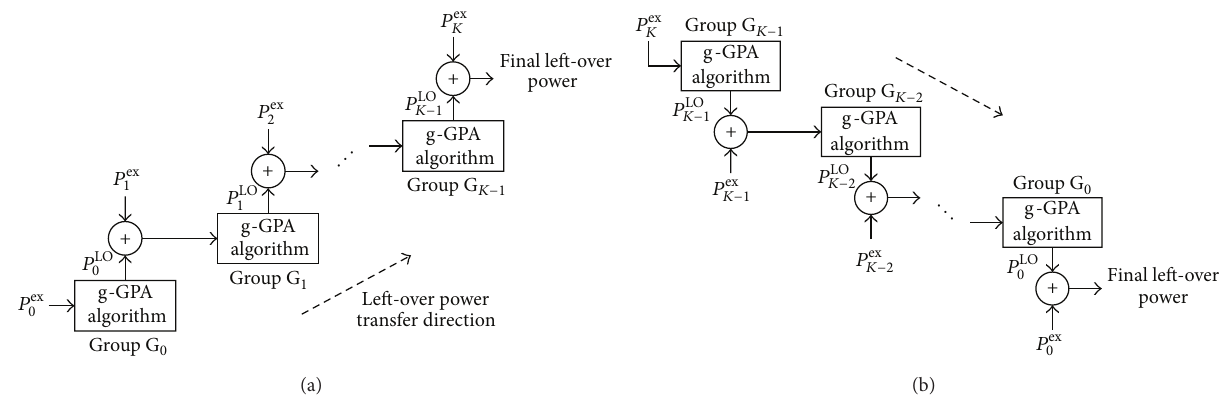
Figure 3: Algorithmic arrangements for (a) Mu-GPA algorithm and (b) Md-GPA algorithm with final left-over powers given, respectively, in (16) and